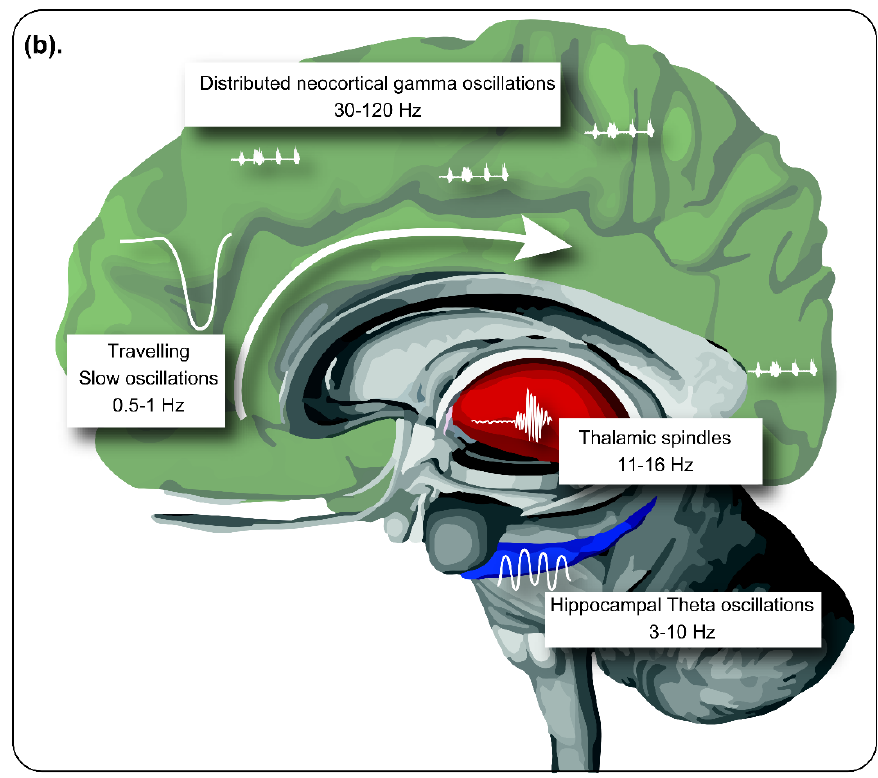
Figure 1. Role of sleep in memory consolidation. ( a ) During wakefulness, new memories are encoded by neuronal assemblies distributed within the neocortex and the hippocampal formation, integrating contextual information. During sleep, in absence of external inputs, memory reorganization is performed, reinforcing some neuronal assemblies by reactivation of the hippocampal-neocortical and thalamocortical circuits. Neural plasticity allows the consolidation of the stronger hippocampal-independent neocortical connections, together with the extinction of weak memory traces. ( b ) Neural oscillations hierarchically coupled allow memory processing during sleep. Slow oscillations propagate across cortical areas during Non-Rapid Eye Movement (NREM) sleep following a craneo-caudal direction, exhibiting upstates and downstates. During the downstates, neuronal rest is observed, while during upstates, highly synchronous discharges are observed, with replay of previous neuronal assemblies, coupled with sleep spindles originated in the thalamus. REM sleep is characterized by prominent theta waves in the hippocampal formation among other structures, coupled to gamma activity distributed within the neocortex. In this period, place-cells and grid cells exhibit a replay, allowing consolidation of contextual memory. Modified from Born and Wilhelm (2012) [42].